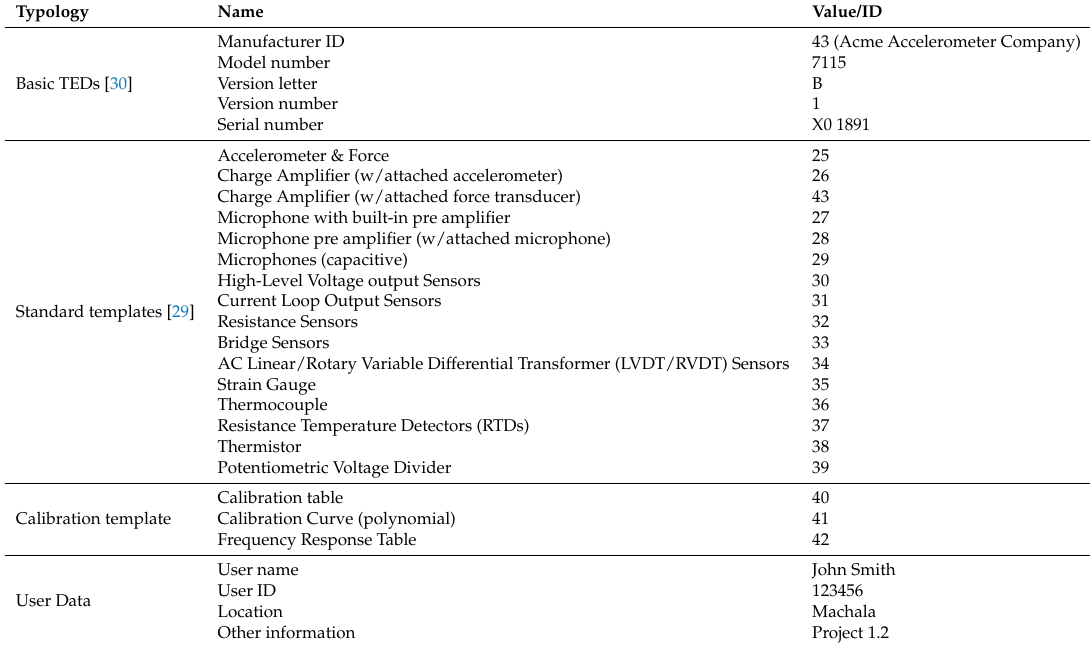
Table 1. Examples of Transducer Electronic Data (TED)